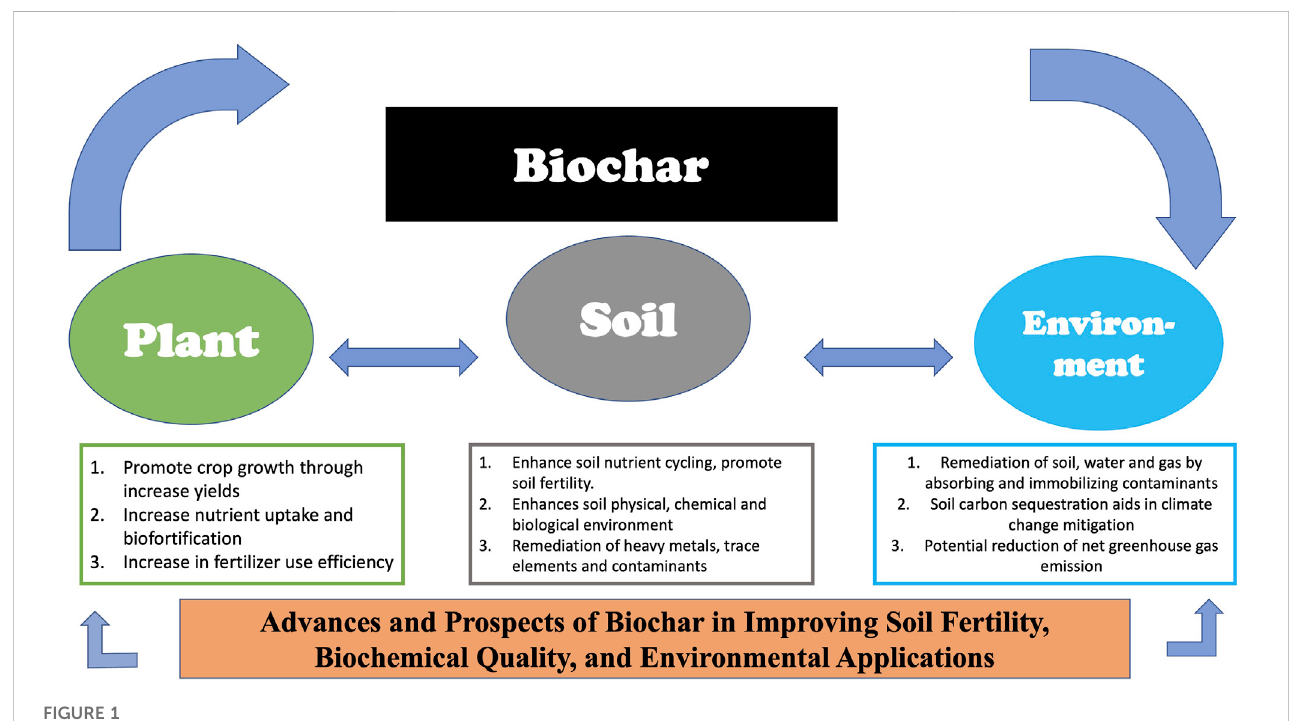
FIGURE 1 Application of biochar in